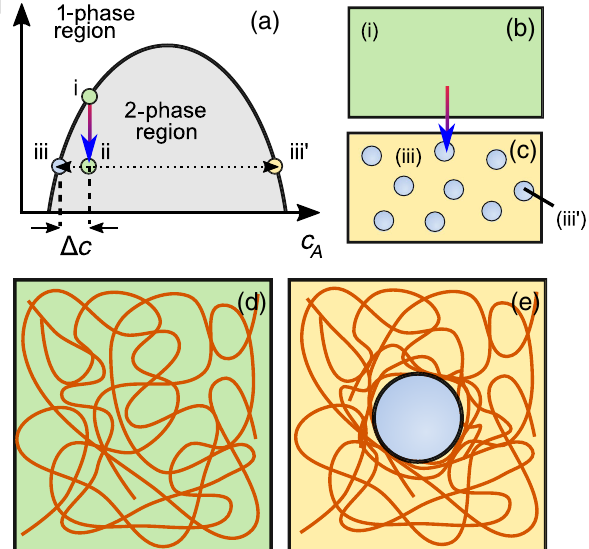
FIG. 1. Phase separation of a liquid mixture in a polymer network. (a) – (c) Schematic diagram of simple liquid-liquid phase separation in a system with an upper-critical solution temper- ature. Point (i) on the phase diagram indicates a marginally stable mixture where the majority component B is saturated with a dilute component A . Upon cooling to (ii), the system sponta- neously separates into two phases, a continuous phase (iii) with a low concentration of A and a droplet phase rich in A (iii ’ ). (d,e) Schematics of (d) a polymer network swollen by a mixture of A and B [at point (i) in the phase diagram], and (e) the same system after quenching to (ii) and phase separating. Note that the droplet must deform the network in order to grow beyond the mesh